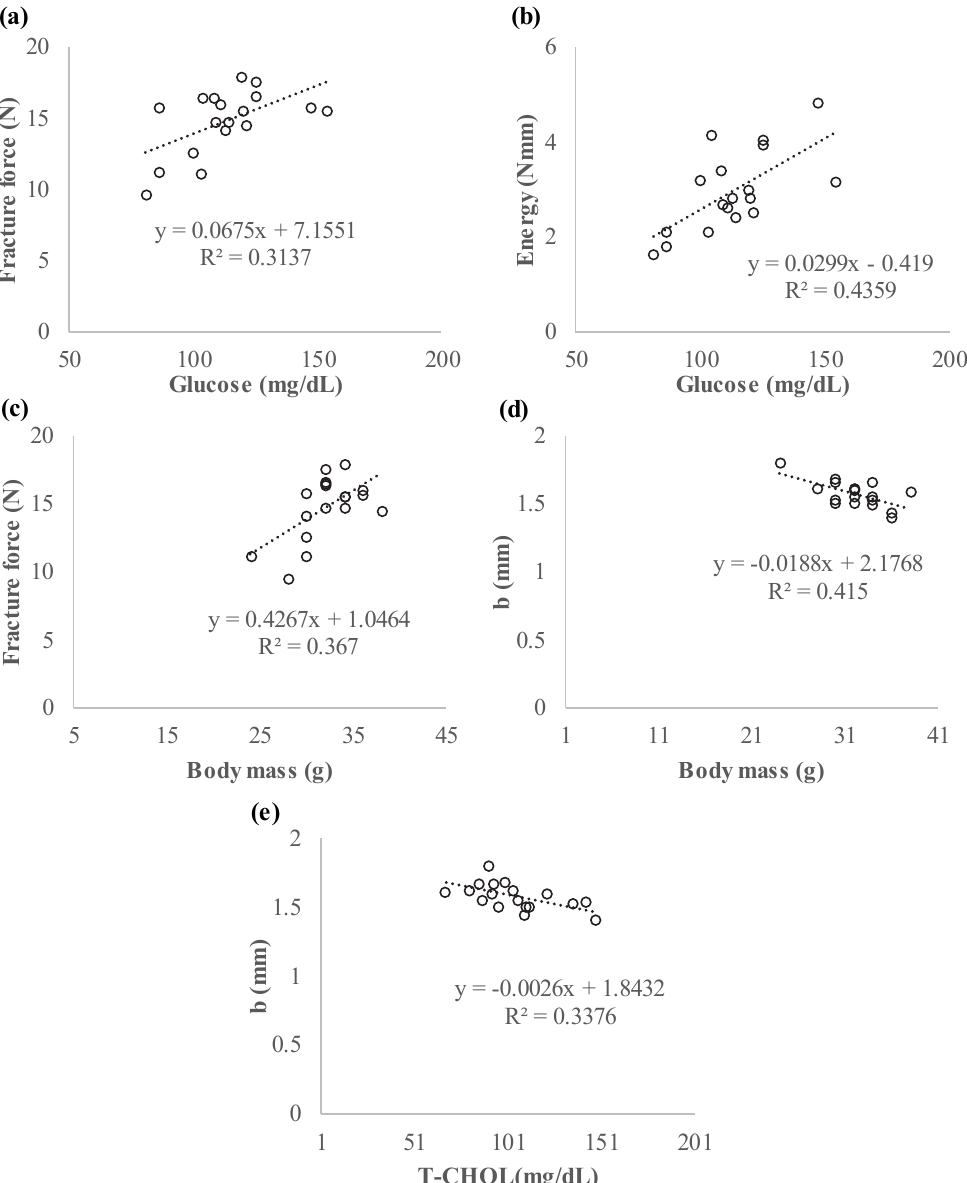
Figure 5: Correlations between biomechanical parameters, body mass and biochemical measurements.